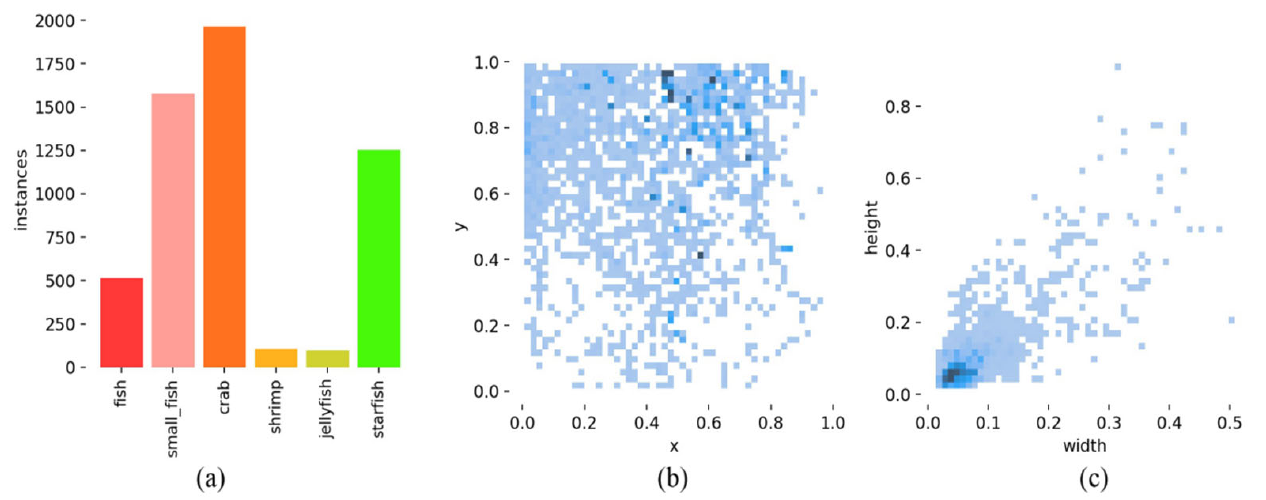
Figure 11. Statistical results of the Brackish dataset: ( a ) bar chart of the number of targets in each class; ( b ) normalized target location map; ( c ) normalized target size map.